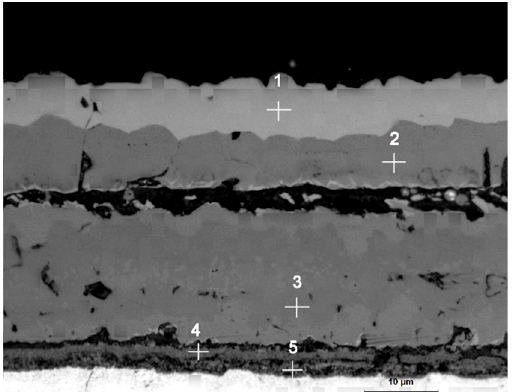
Figure 8. Cross-sectional morphology and EDS analysis at different positions of the iron oxide scale at 1000 °C. Table 3. The elemental distribution of the energy spectrum.